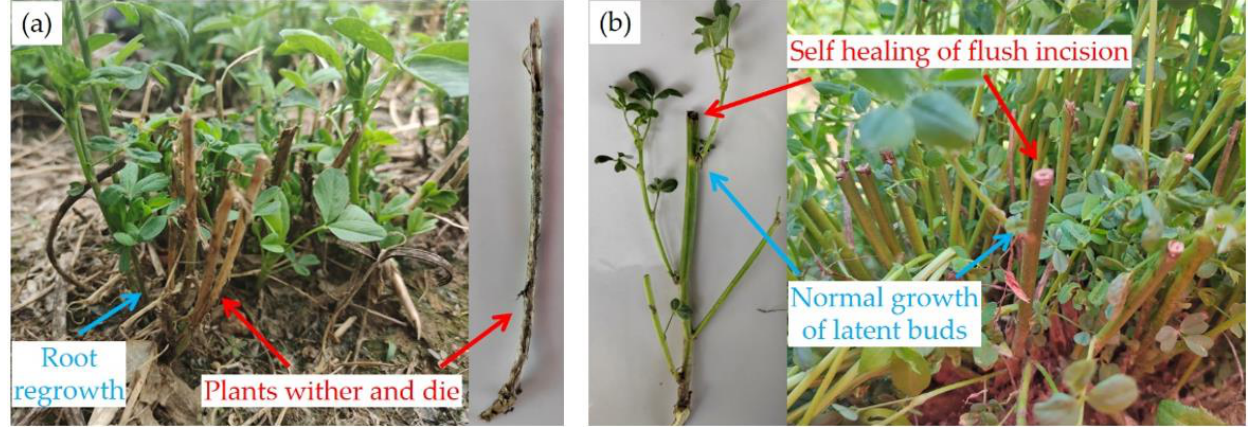
Figure 7. Comparison of macro morphology of Alfalfa after 10 days of growth after cutting with different blades: ( a ) commercial blades cutting; ( b ) carbon-nitron-boronized blades cutting.